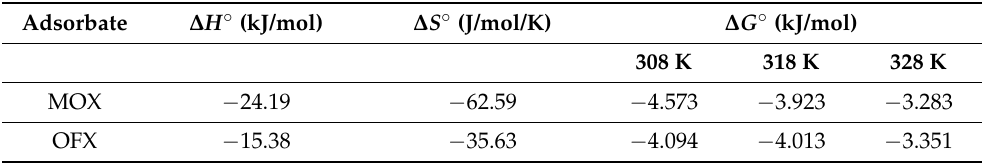
Table 5. Thermodynamic parameters of MOX and OFX adsorption onto Met-GO/SA at different temperatures (308–328 K).